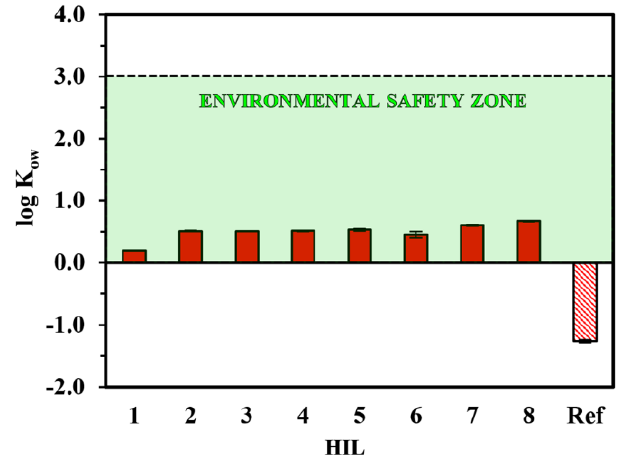
Figure 3. The values of the logarithm of the octanol–water partition coefficient of the obtained ILs ( 1 – 8 ) in comparison to iodosulfuron-methyl sodium salt (Ref).